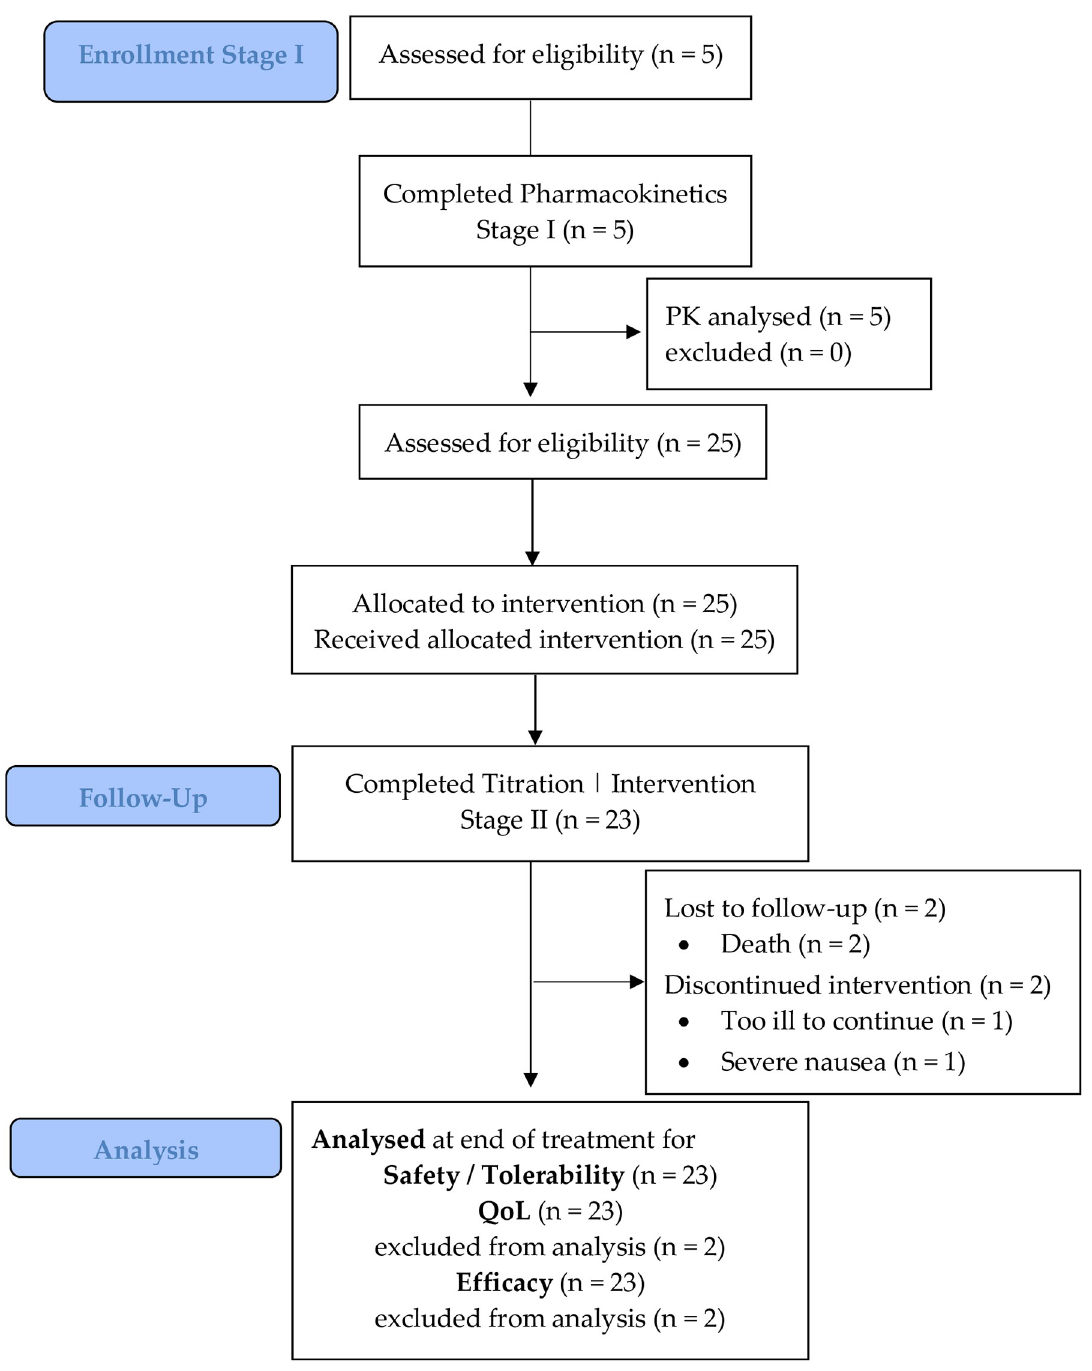
Fig 1. CONSORT diagram for Single Ascending (SAD) and Multiple Ascending Dose (MAD) Stages I and II pilot study. In Stage I (pharmacokinetics) eligible patients administered one dose (2 sprays) on day 1 and three doses (6 sprays) on day 2. In Stage II after baseline assessments, patients commenced with one spray of the cannabis-based medicine (1.25 mg each of Δ 9-THC and CBD in 0.15 mL) every 4 to 8 hours while awake for 3 days, then dose escalated to two sprays every 4–8 hours while awake for 3 days, and finally dose escalated to three sprays every 4–8 hours while awake for 3